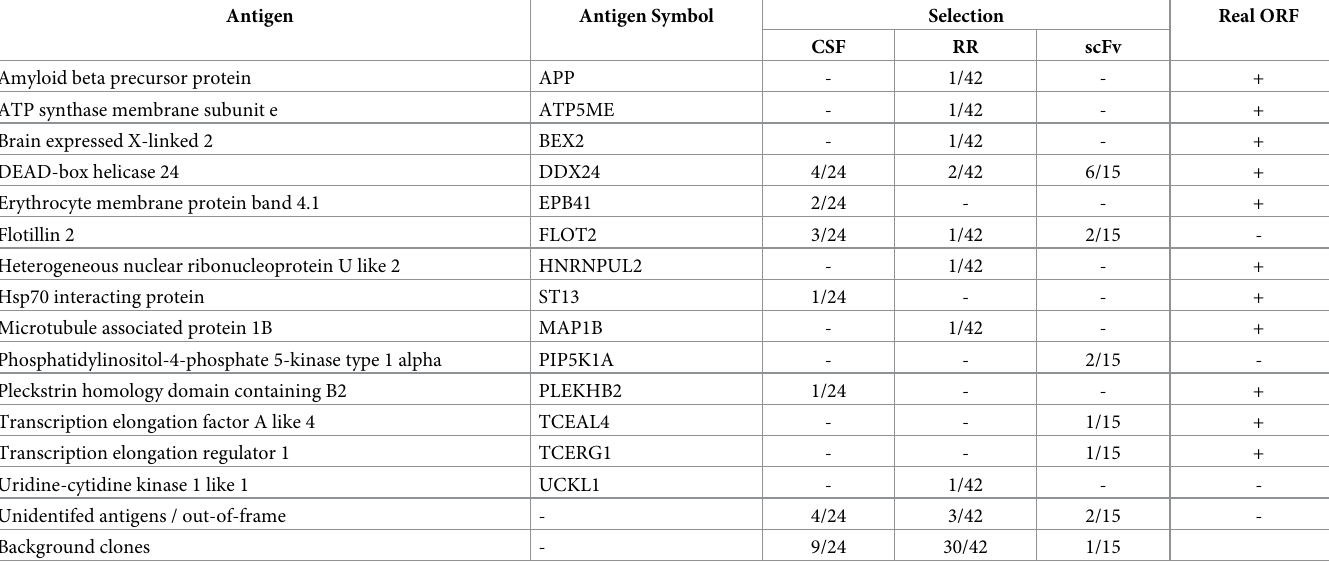
Table 2. Summary of putative antigens identified by the selections of the HB phage display library.